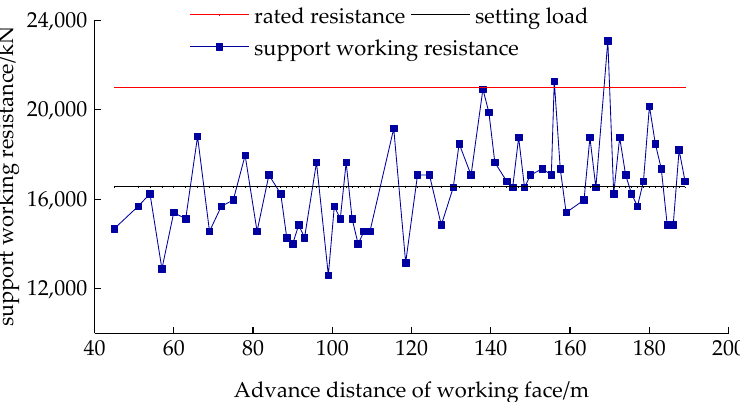
Figure 10. Law of WR in periodic weighting.